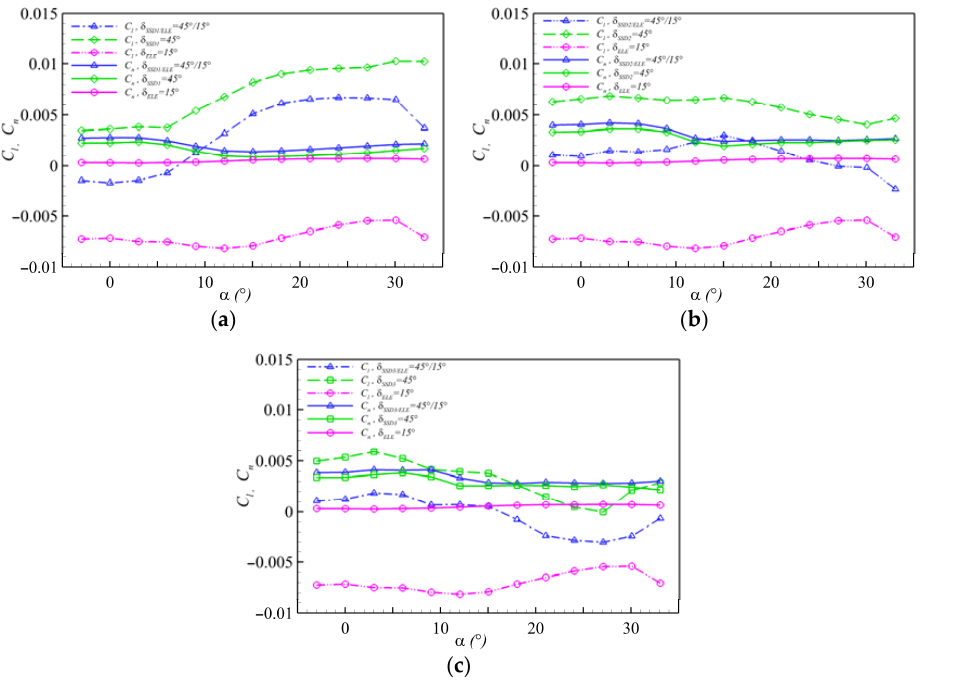
Figure 10. Yawing and rolling moments comparison of the elevon, SSDs, and corresponding FCRs, Ma = 0.2, Re = 3.98 × 10 7 : ( a ) The elevon, SSD1 and the corresponding FCR; ( b ) The elevon, SSD2 and the corresponding FCR; ( c ) The elevon, SSD3 and the corresponding FCR.